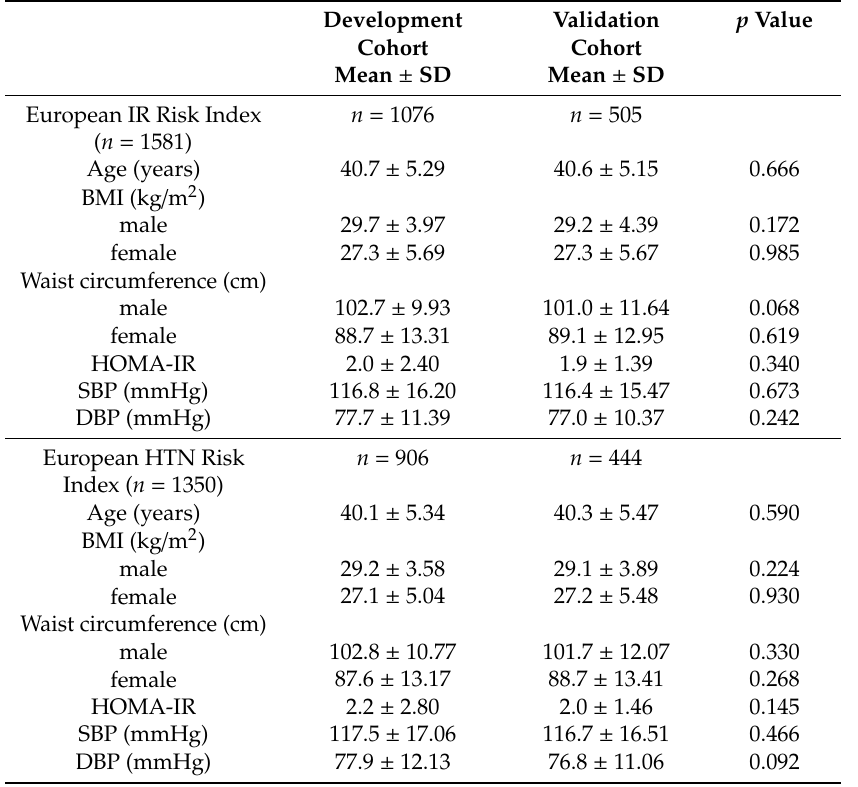
Table 1. Descriptive characteristics of the European IR Risk Index and European HTN Risk